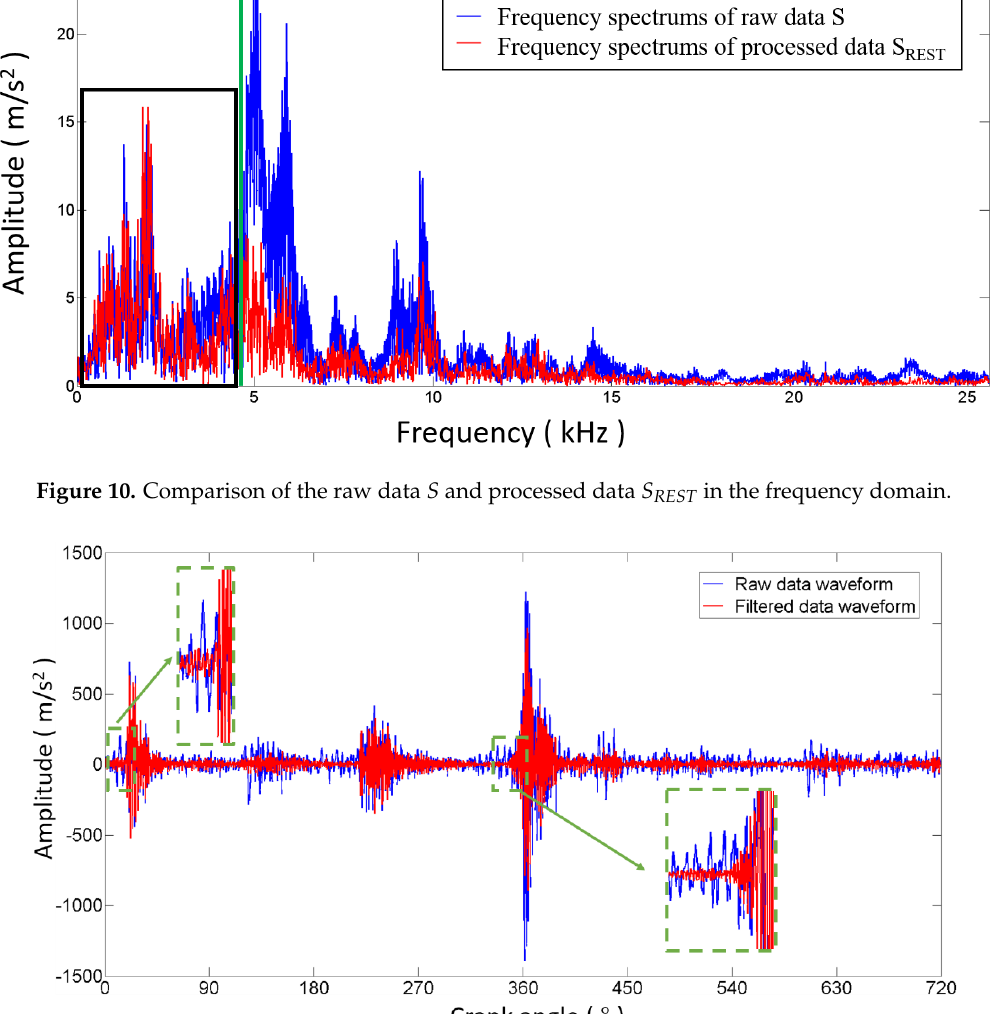
Figure 11. Comparison of the raw data and filtered data waveforms in the angle domain.